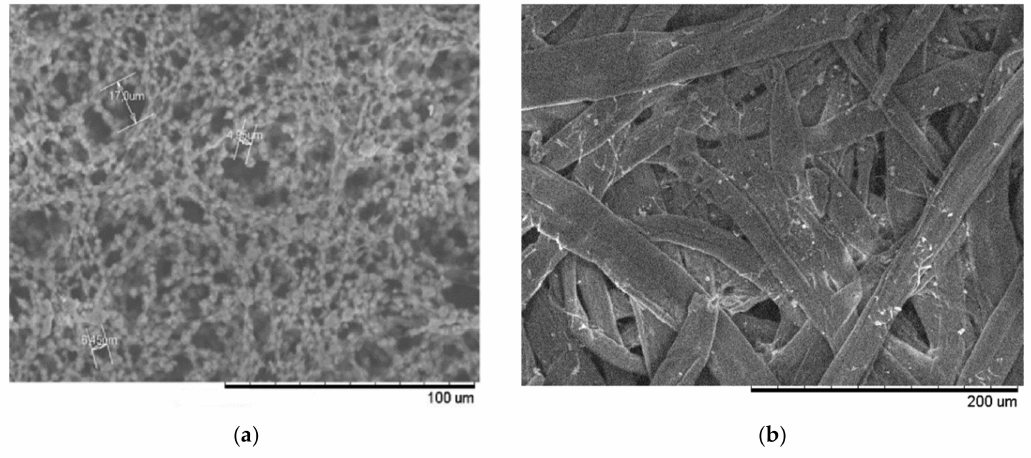
Figure 4. SEM images of ( a ) NC 5 µ m porous structure and ( b ) FM fibers.